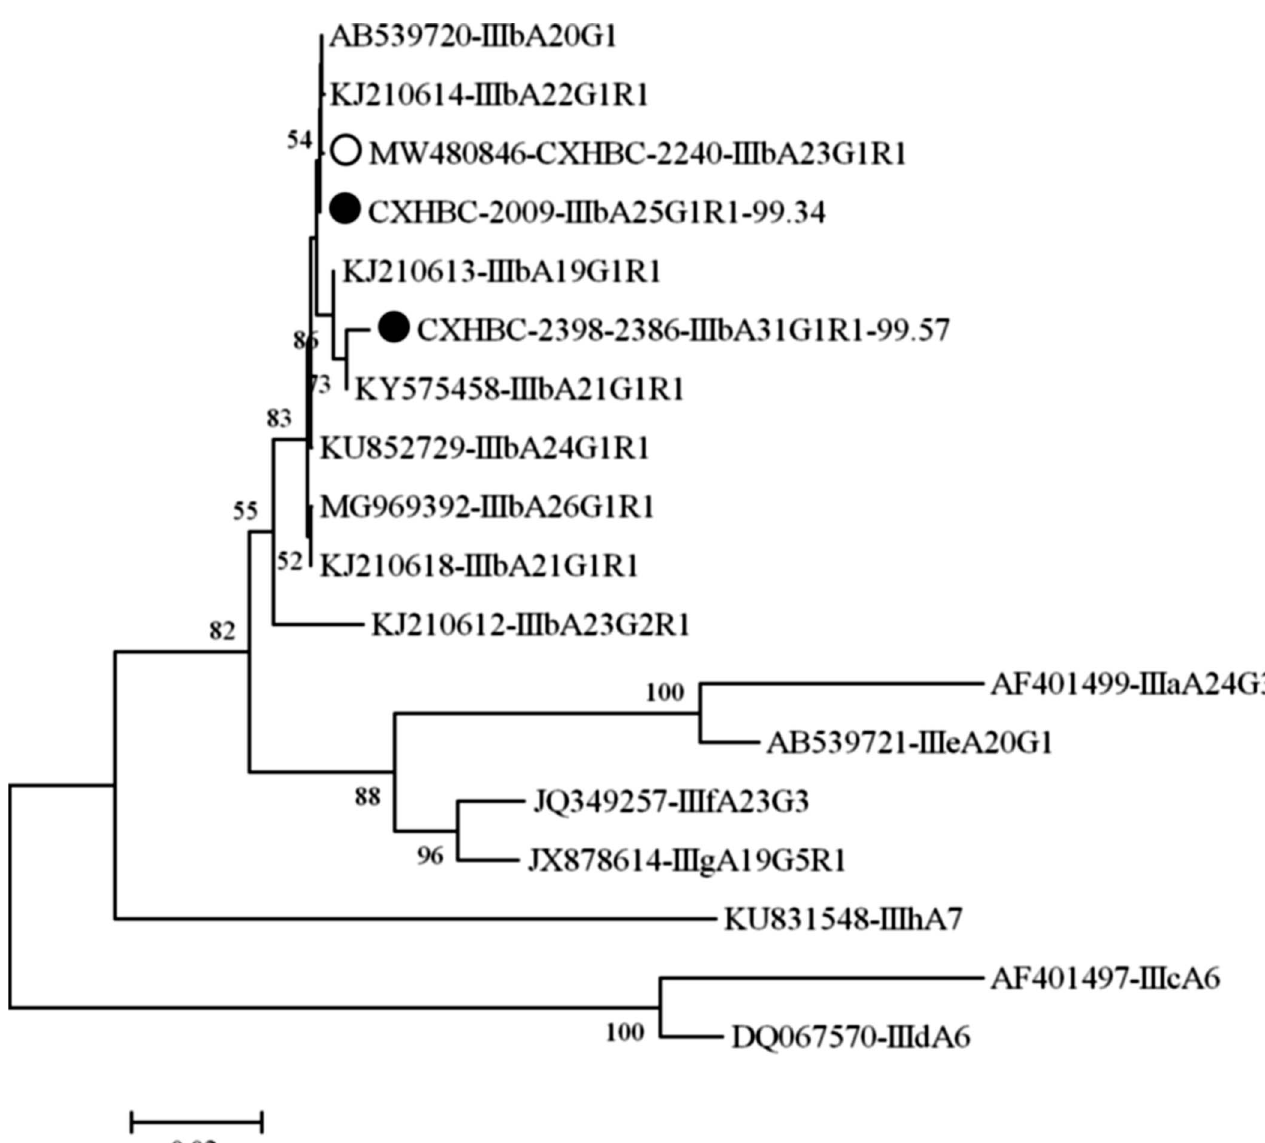
Figure 2. Phylogenetic tree based on the N-J analysis of gp60 sequences of C. meleagridis . Phylogenetic relationships of C. meleagridis subtypes identi fi ed in chicken here and parts of other known subtypes deposited in GenBank were inferred by a neighbor-joining analysis of gp60 sequences of C. meleagridis based on genetic distances by the Kimura two-parameter model. The numbers on the branches are percent bootstrapping values from 1000 replicates. The triangles fi lled in black and white indicate novel and known subtypes identi fi ed in this study,